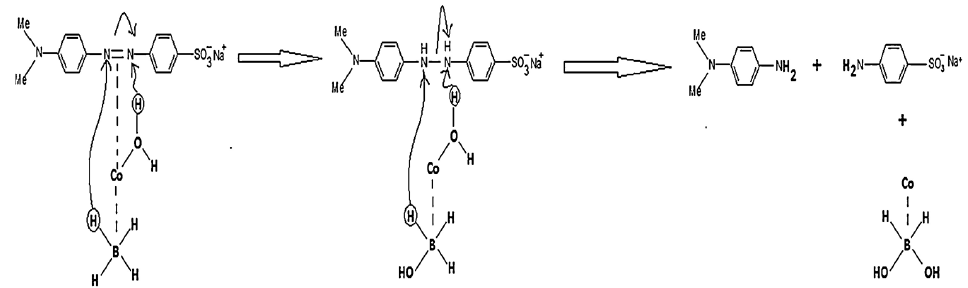
Figure 2. Mechanism of reduction of methylene orange [28].